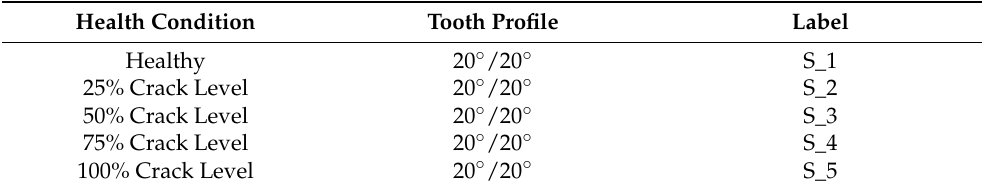
Table 4. The classes identified for standard (20 ◦ /20 ◦ ) profiled involute spur gears. Health Condition Tooth